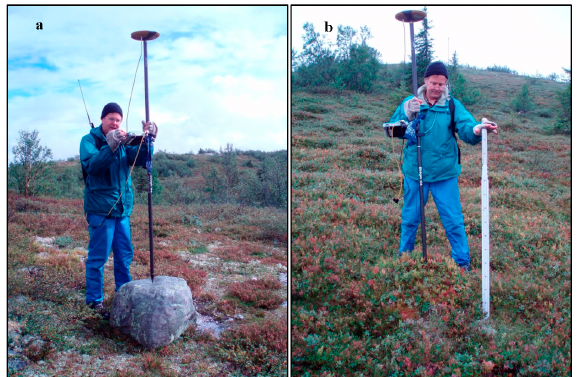
Figure 2. Field measurements. Examples of two non-tree objects: ( a ) Rock; and ( b ) “Organic” (tussocks, hummocks, and rocks covered with moss and other vegetation). Photographs taken 29 August 2006.